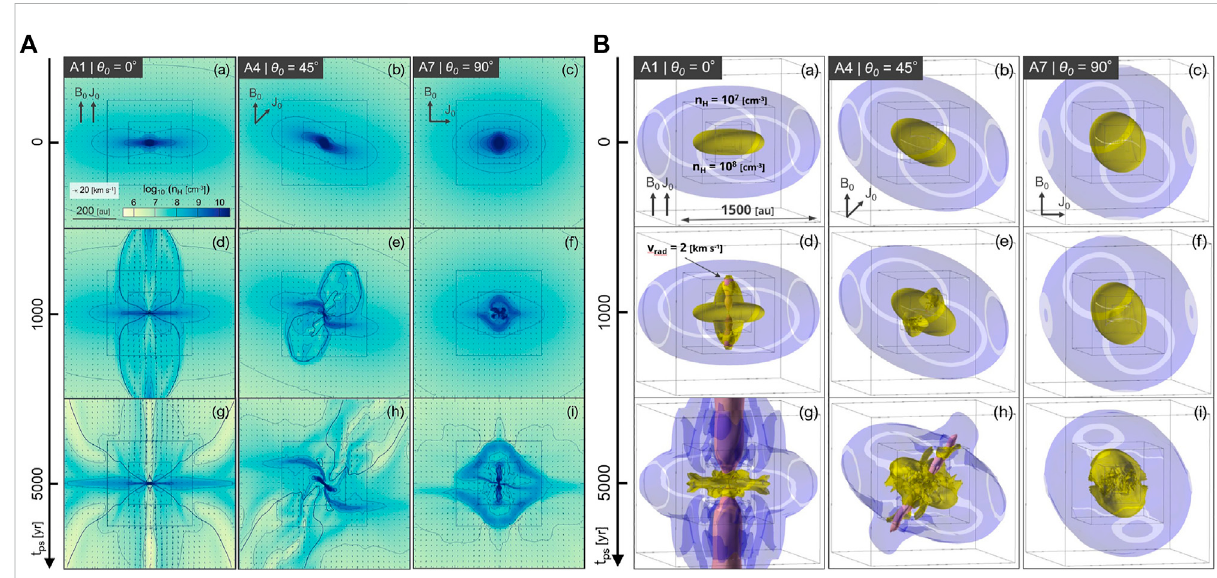
FIGURE 6 (A) Density (color and contours) and velocity (arrows) distributions in models from Hirano et al. (2020), implementing different angles between the magnetic fi eld initial direction and the initial rotation axis of the core, at t ps = 0, 1,000 and 5,000 years after protostar formation. The box size is 780au. (B) Three-dimensional structures for the same models, highlighting two isodensity contours in purple and yellow, and one isovelocity contour of radial velocity v rad = 2 kms (in red). Note the absence of an out fl ow in the case of orthogonal con fi guration (third column): this case thus seems unrealistic considering the prevalence of out fl ows observed around low-mass